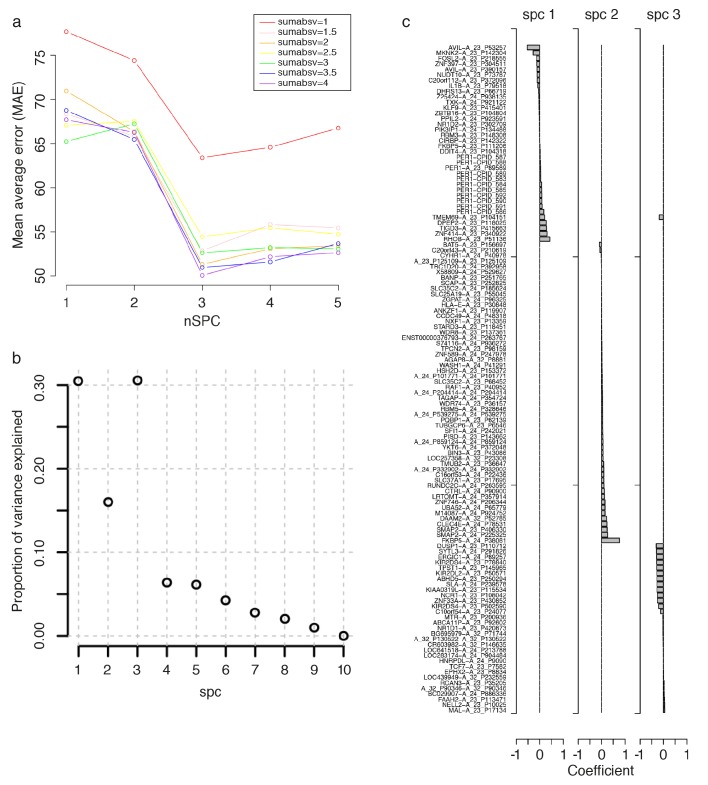
Parameter selection for constructing a Zeitzeiger based model.To build a Zeitzeiger predictor, given a training data set, there are two parameters that need to be optimized: ‘sumabsv’, which controls the number of features to be used, and ‘nSPC’, which controls the number of principal components that best describe (explain) the variance in mRNA abundance, measured by features, over time. The performance of differing combinations of sumabsv and nSPC were assessed using cross-validation (see Materials and methods). Panel a shows the change in performance, measured by mean average error (MAE), between the predicted and true circadian phase of samples in the training set, of the sumabsv input parameter of the Zeitzeiger algorithm across different nSPC values. The sumabsv value (4) resulting in the smallest MAE is optimal. Panel b shows the proportion of variance explained of differing values of the nSPC input parameter when sumabsv = 4. The nSPC value (3) giving the highest proportion of variance explained is optimal. (c) mRNA abundance features identified for the construction of the final Zeitzeiger model, using the parameters sumabsv = 4 and nSPC = 3. Bar chart represents the contribution (i.e. weight, [coefficient on x-axis]) of a feature to each of the three components spc1, spc2 and spc2. Note that there are multiple, different features (probes) that target a gene on the microarray platform we have used (e.g. multiple CPID probes targeting PER3; see GEO [Barrett et al., 2013; Accession number: GPL15331]).